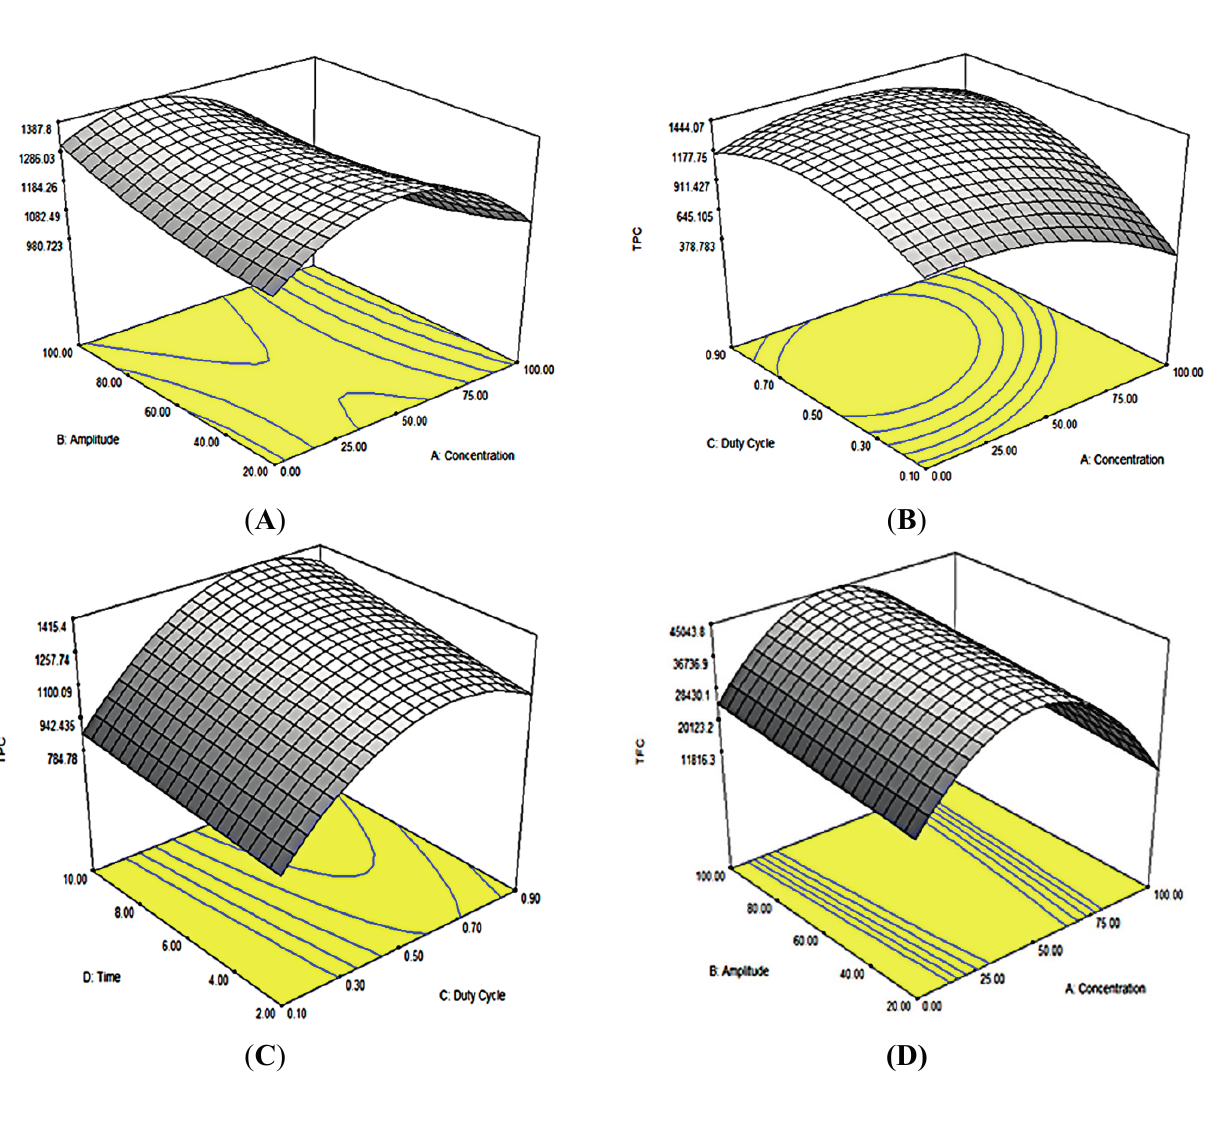
Figure 1. Response surface plots of the total phenolic contents: ( A ) ethanol concentration and amplitude (duty cycle 0.9 W/s and time 10 min); ( B ) ethanol concentration and duty cycle (amplitude 20% and time 10 min); ( C ) duty cycle and time (ethanol concentration 54.77% and amplitude 20%); of the total flavonoid contents: ( D ) ethanol concentration and amplitude (duty cycle 0.9 W/s and time 10 min); of ABTS •+ radical cation: ( E ) ethanol concentration and duty cycle (amplitude 20% and time 10 min); of DPPH• radical scavenging activities: ( F ) ethanol concentration and amplitude (duty cycle 0.9 W/s and time 10 min); ( G ) ethanol concentration and duty cycle (amplitude 20% and time 10 min); ( H ) ethanol concentration and time (amplitude 20% and duty cycle 0.9 W/s ); ( I ) amplitude and duty cycle (ethanol concentration 54.77% and time 10 min); ( J ) duty cycle and time (ethanol concentration 54.77% and amplitude 20%), of Orthosiphon stamineus extract as affected by ethanol concentration, amplitude, duty cycle and extraction time in